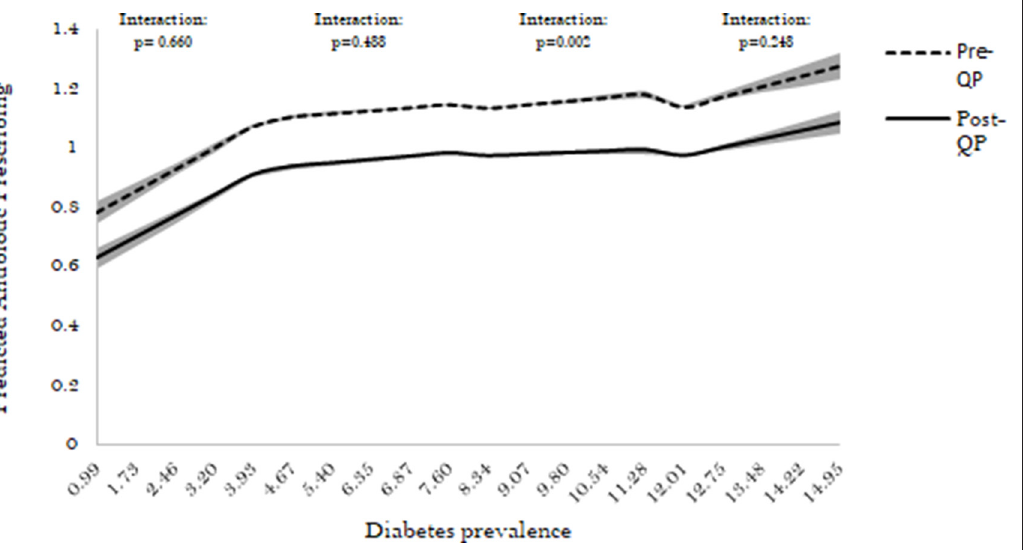
Figure 2 Association between diabetes prevalence and antibiotic prescribing before and after the 2015–2016 QP (for diabetes prevalence spline terms). The shaded portion around the line represents the 95% CI. QP = Quality Premium